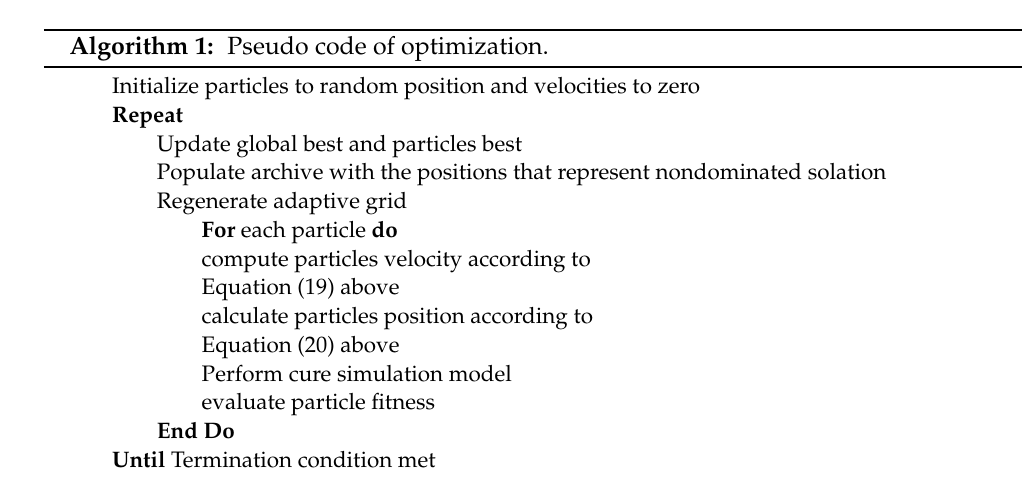
Algorithm 1: Pseudo code of